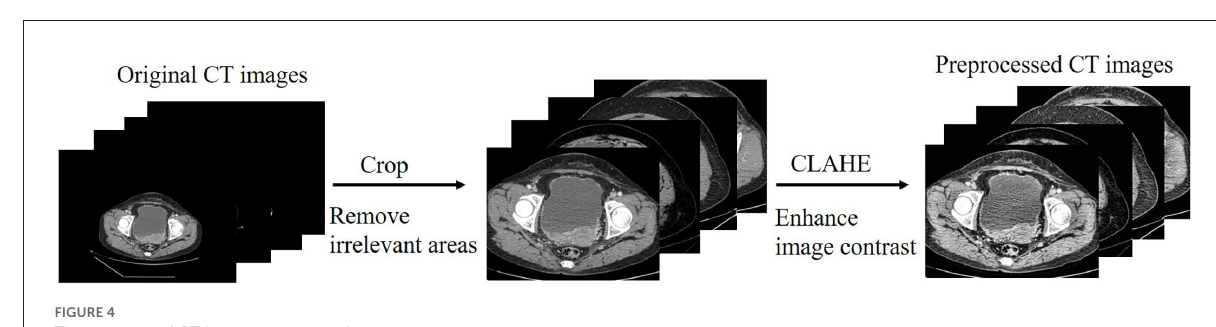
The histogram distribution of image pixels is more balanced and the image contrast is stronger after enhancement by CLAHE algorithm. The process of CT image preprocessing is shown in Figure